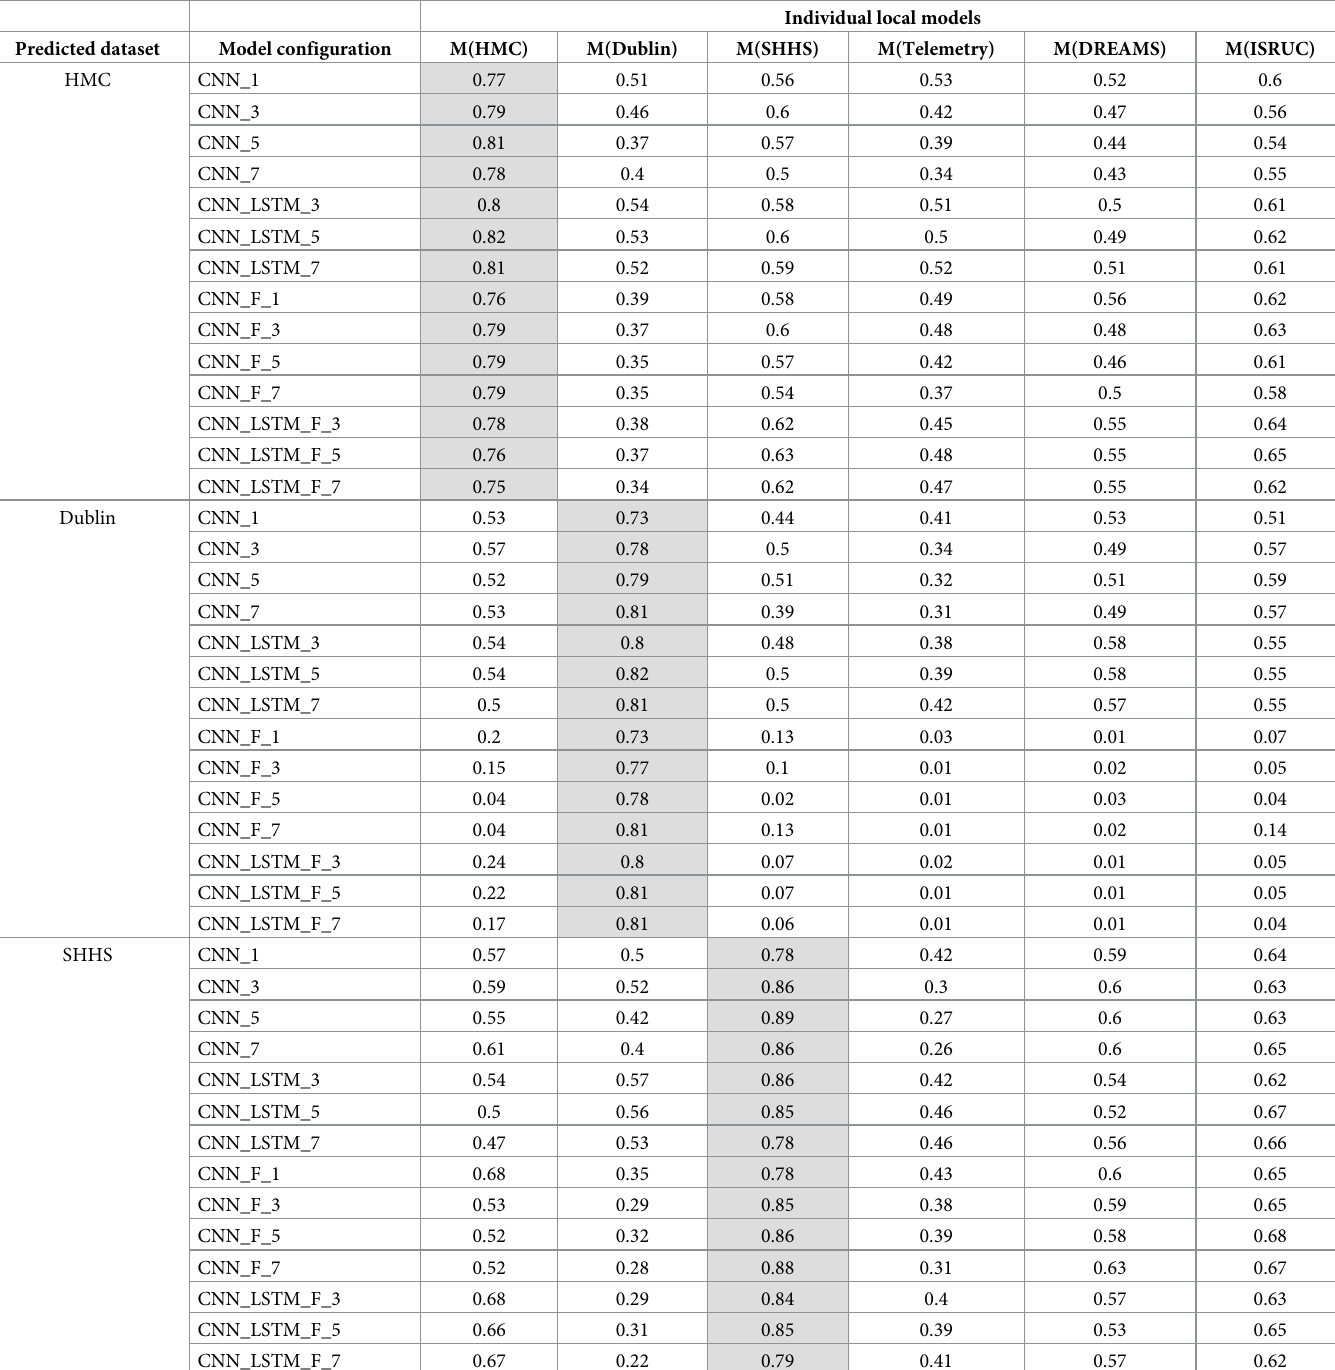
Table 2. Performance results of the individual local models on the external validation